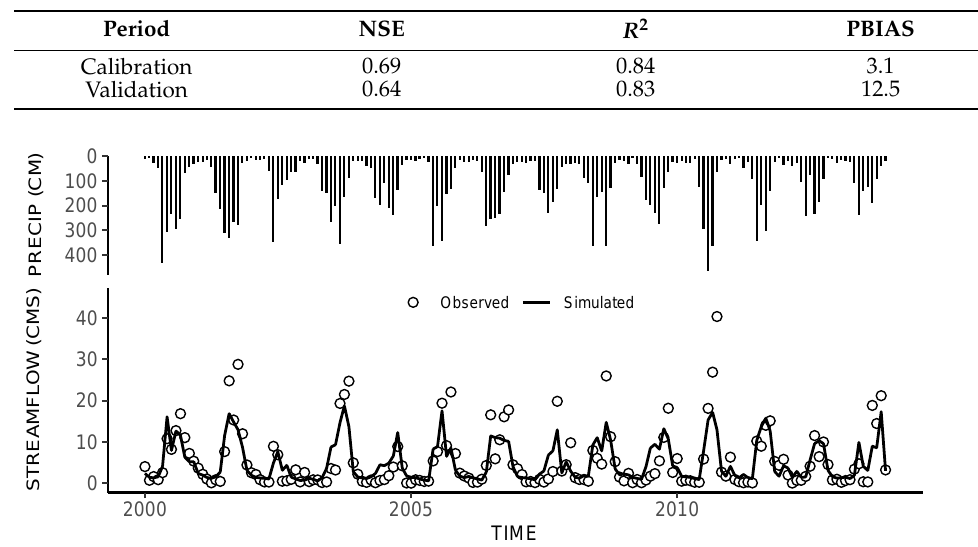
Figure 7. Huazuntlan River Watershed hydrologic response. Top : monthly precipitation; Bottom : observed streamflow (circles) and simulate streamflow (solid